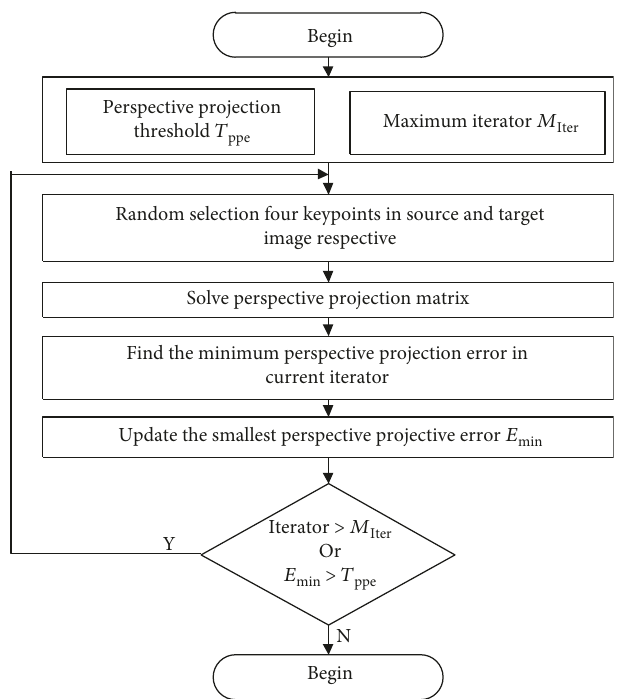
Figure 11: Diagram fl ow of RANSAC algorithm.